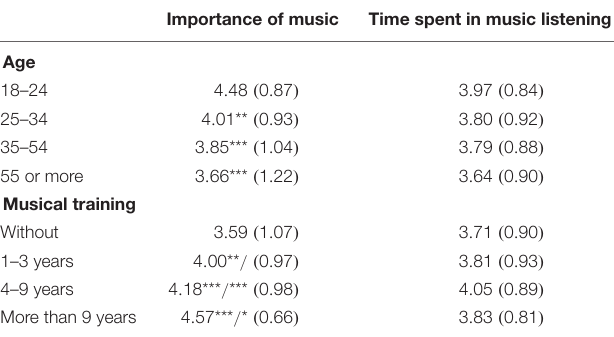
TABLE 6 | Importance of music and Time spent in music listening by age and by musical